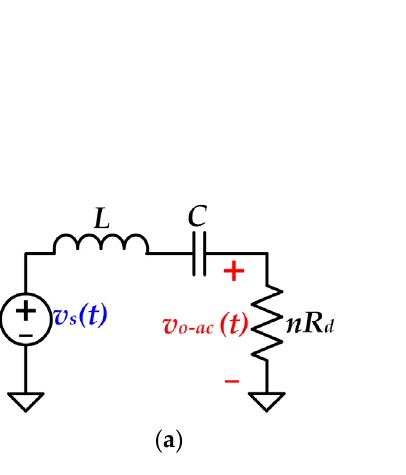
Figure 8. Series-resonant LC circuit characterization: ( a ) Equivalent circuit model. ( b ) Filter response for different Q values.